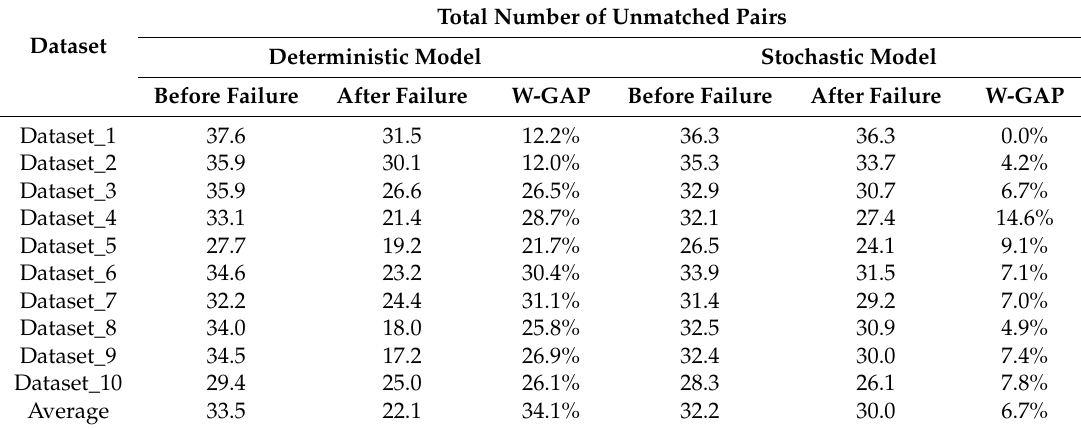
Table 5. Comparison of the sum of the weights when a pair changes its mind.